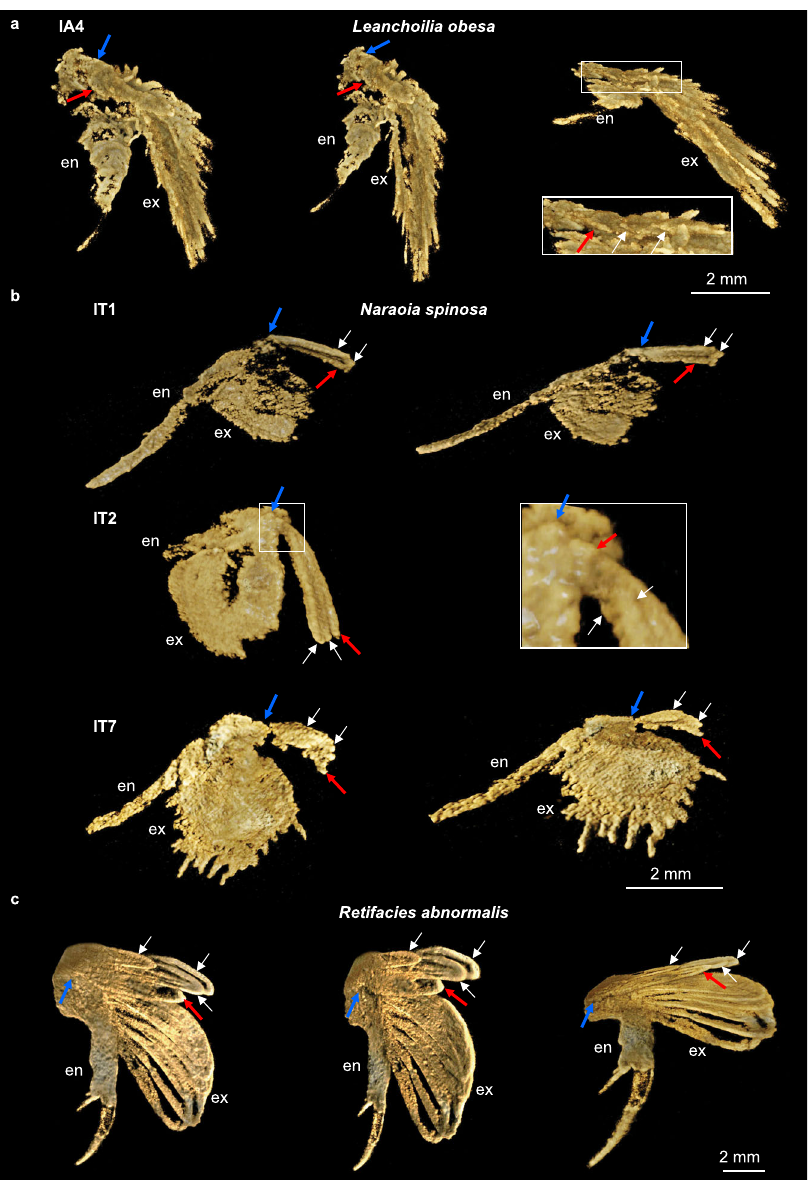
Fig. 2 Computed tomographic images showing exite-bearing appendages. a Leanchoilia obesa (YKLP 13323). b Naraoia spinosa (YKLP 11425). c Retifacies abnormalis (YKLP 11426). Each appendage is shown at different angles to demonstrate the endopodite (en), the exopodite (ex) and the exite consisting of one basal fl ap (red arrow) and several additional ones (white arrows). Blue arrows point to the attachment of the exite. Individual scale bars provided. A n , head appendage n ; l, left; r, right; T n , trunk appendage n . CT images of the entire specimens are available in Supplementary Fig.